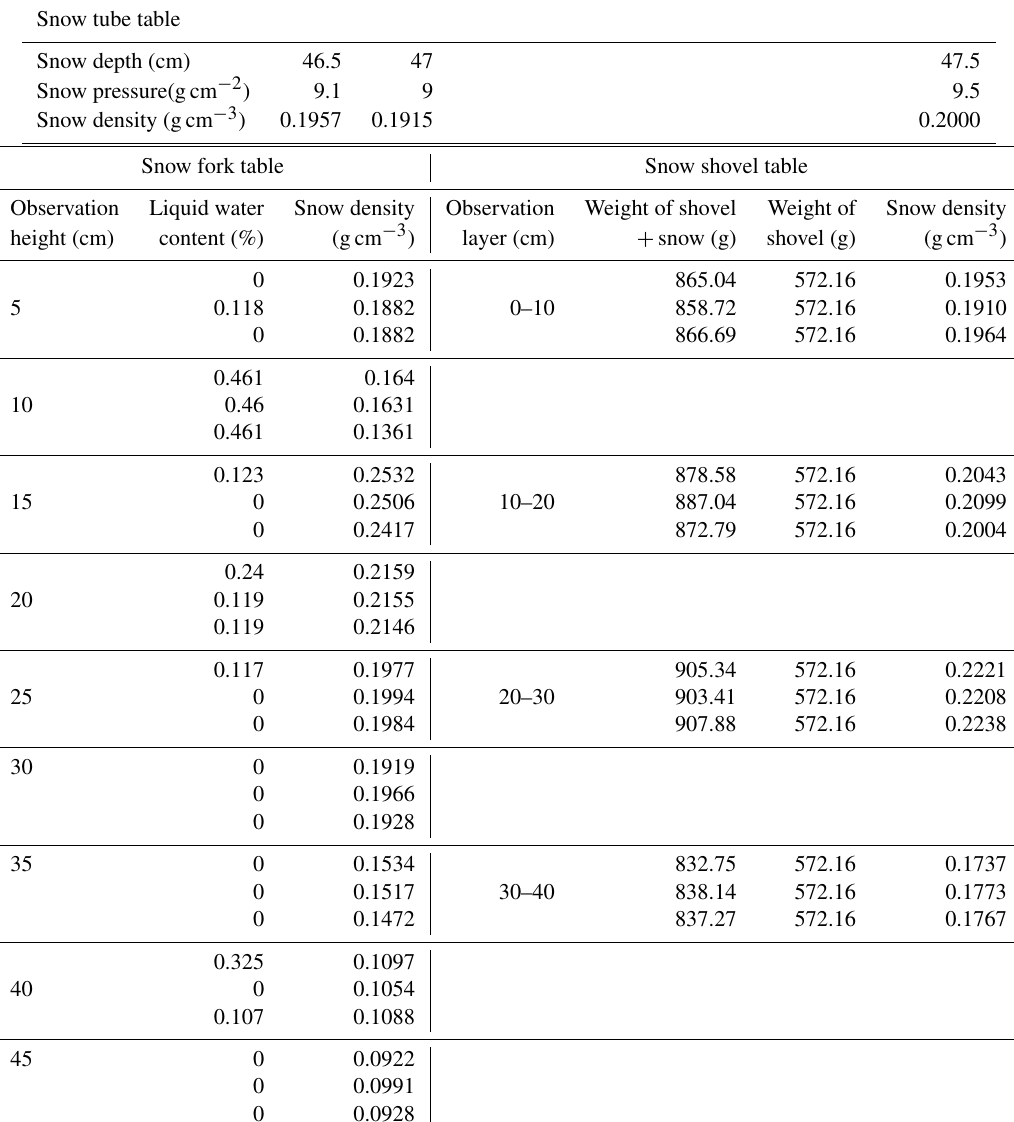
Table A2. An example of record table for snow density observation. Observation date: 11 January 2016; observation time: 09:03–09:40LT; weather: clear; snow depth: 48cm Snow tube